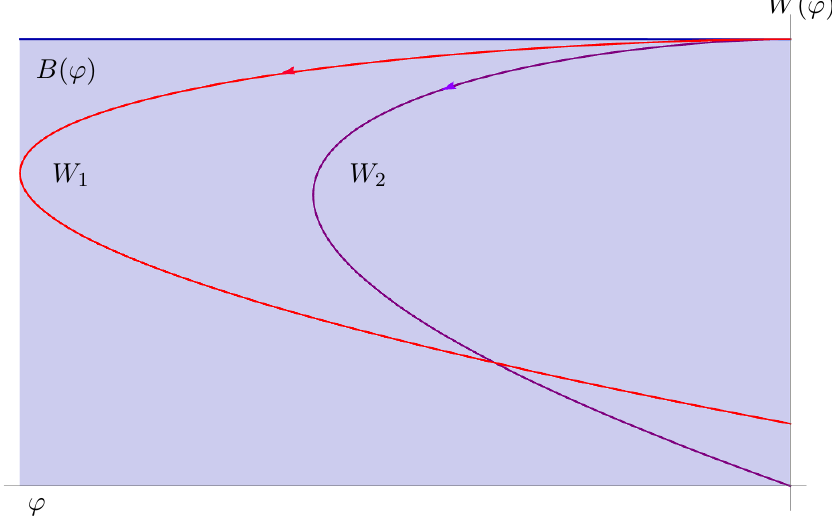
p 3, ’ (cid:3) = 4. W 1 ; 2 are solutions with R < 0, and